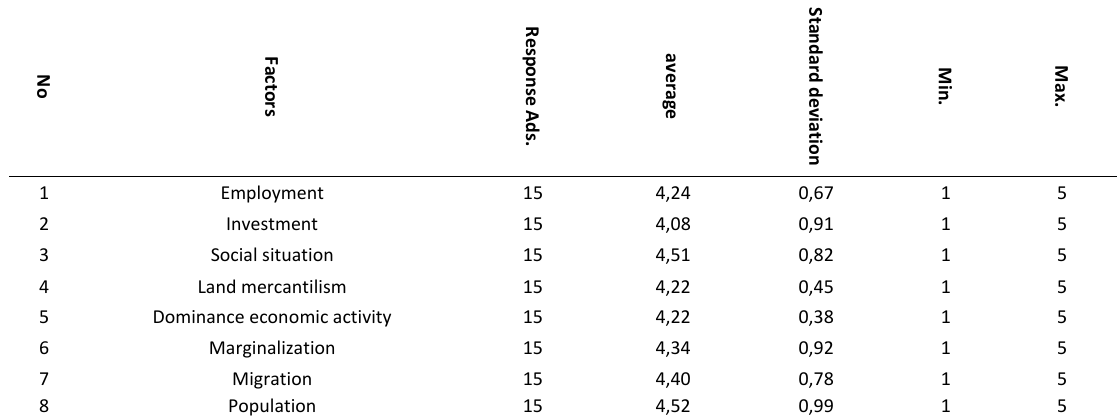
Table 5: Step 3 of the fuzzy method in developing indicators determining the mechanisms affecting urban development, taking into account its sphere of influence